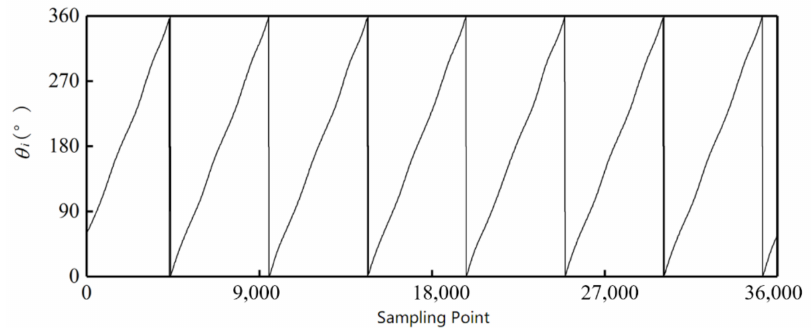
Figure 15. Decoding result for inner alnico.